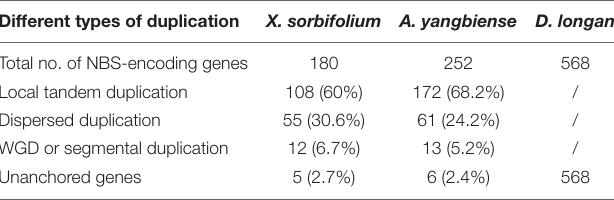
TABLE 3 | Contributions of three duplication types in producing NBS-encoding genes during the evolution of Sapindaceae species. Different types of duplication